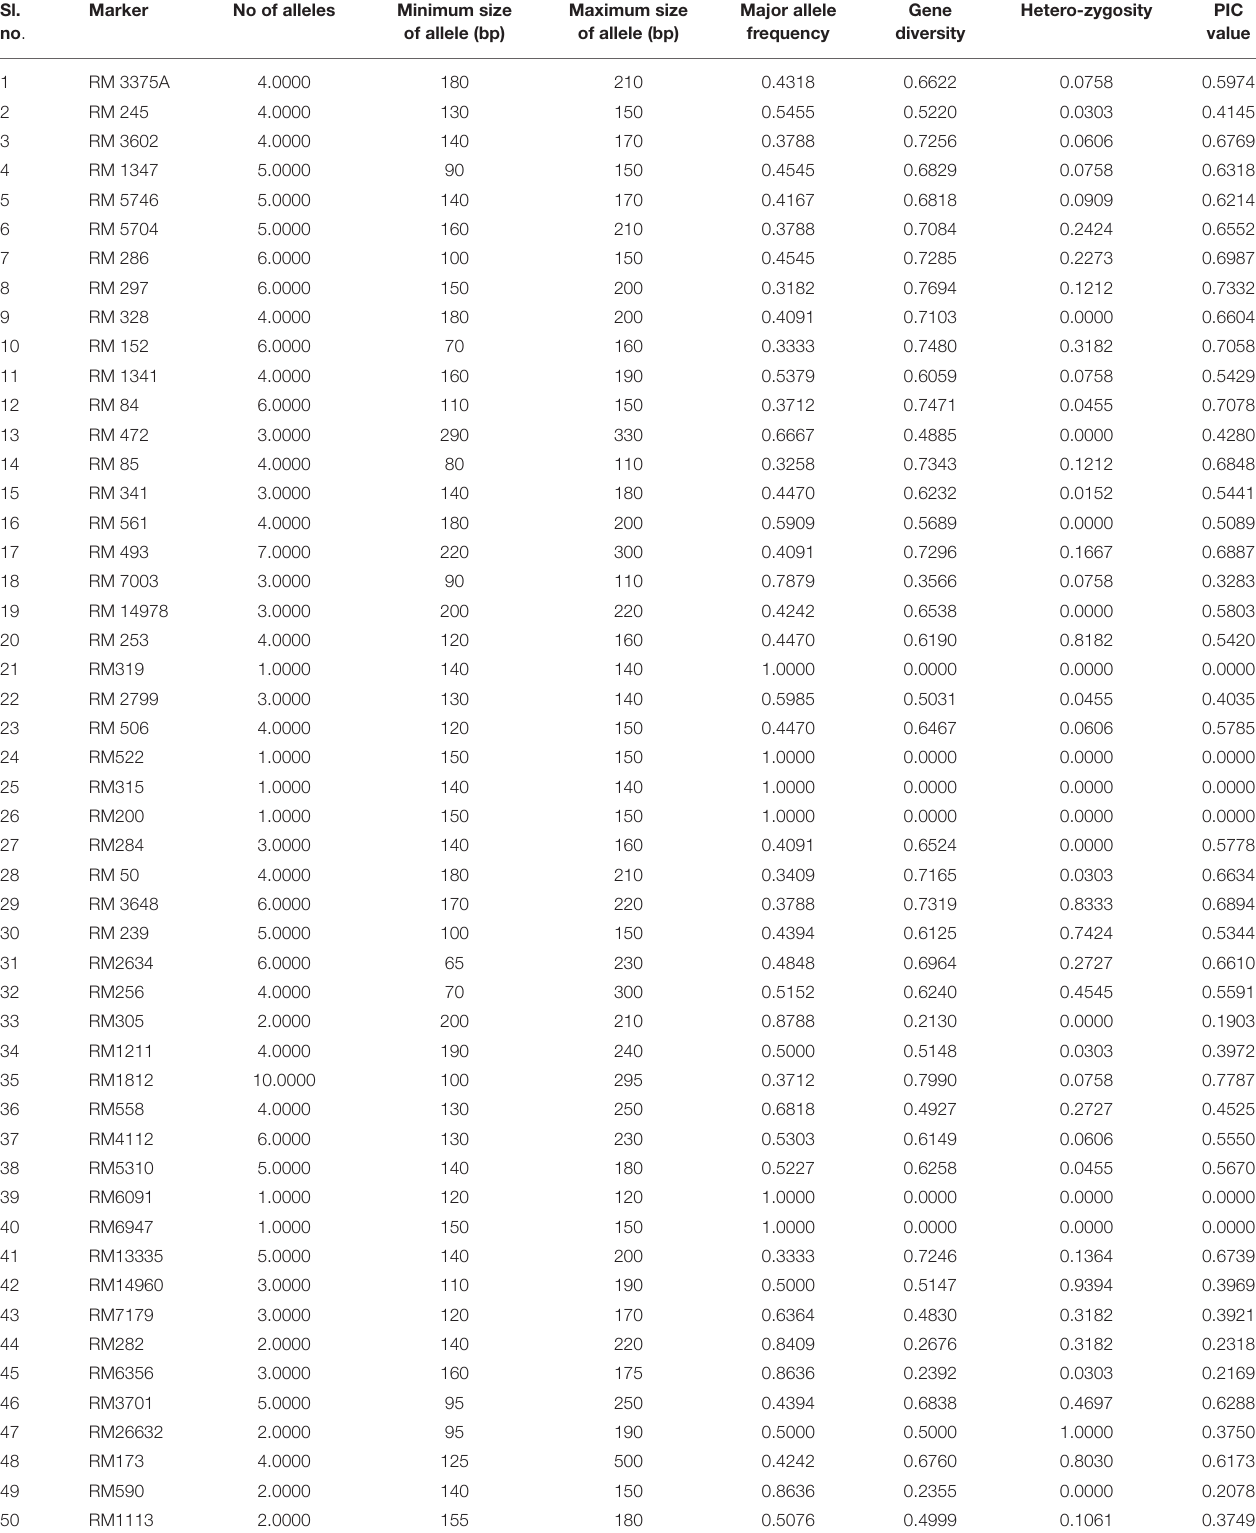
TABLE 3 | Details of SSR loci used for genotyping a set of 60 rice genotypes and their genetic diversity parameters. Sl. no